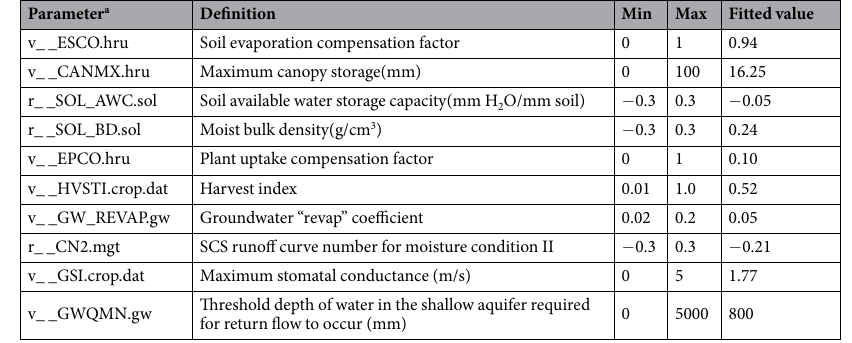
Table 1. Parameters used for SWAT model calibration. a v_ _: parameter value is replaced by given value or absolute change; r_ _: parameter value is multiplied by (1 + a given value) or relative